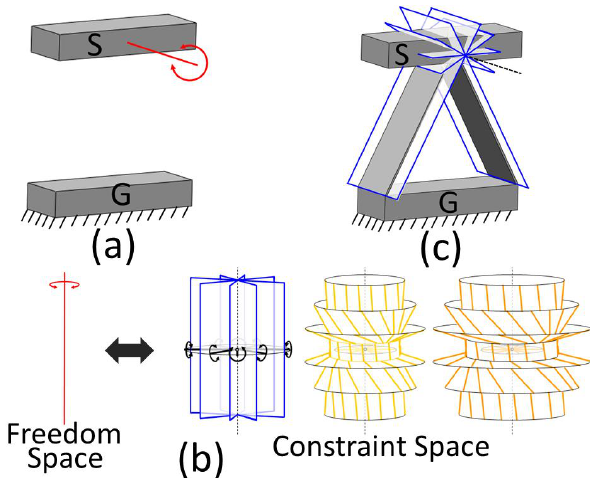
Figure 7. Desired DOFs (a) belong to a freedom space that links to a complementary constraint space (b) within which flexure elements may be selected (c)